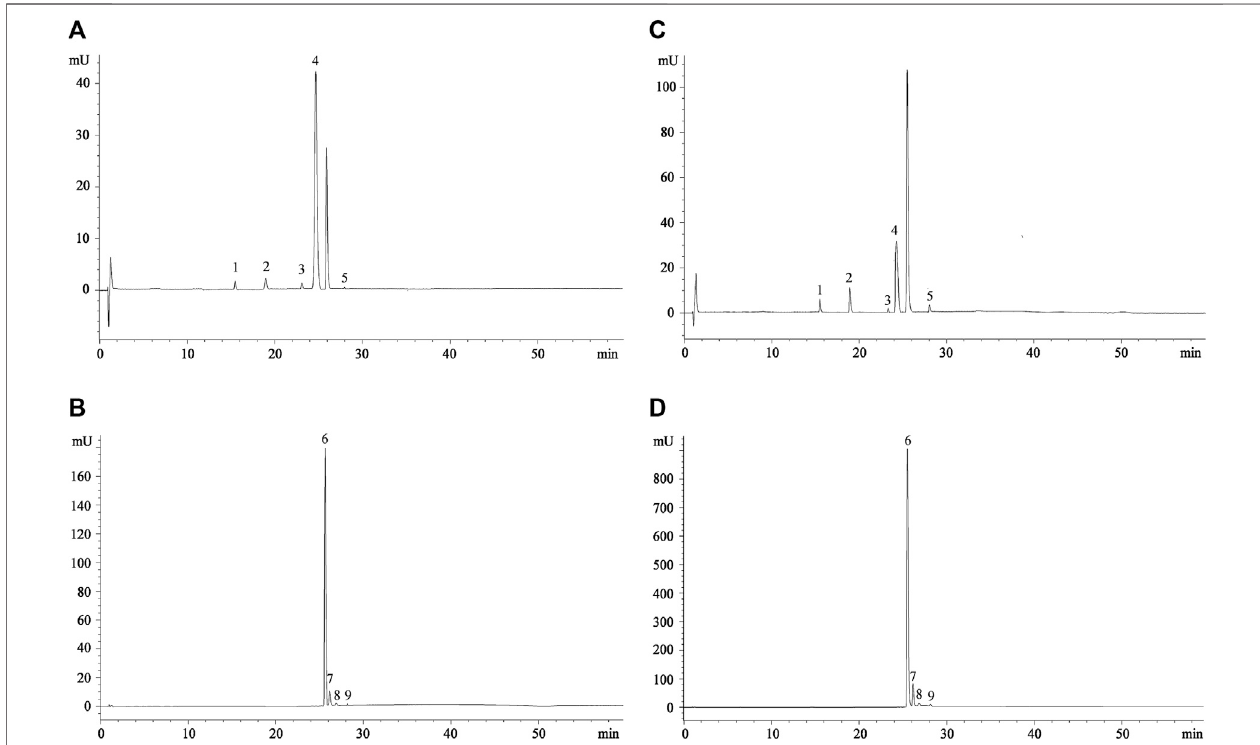
FIGURE 1 | Representative chromatograms of prickly pear fl esh (A,B) and peel extracts (C,D ) acquired at 477 nm (betaxanthins) and 538 nm (betacyanins), respectively. Peak numbers referred to compounds shown in Table 1 .